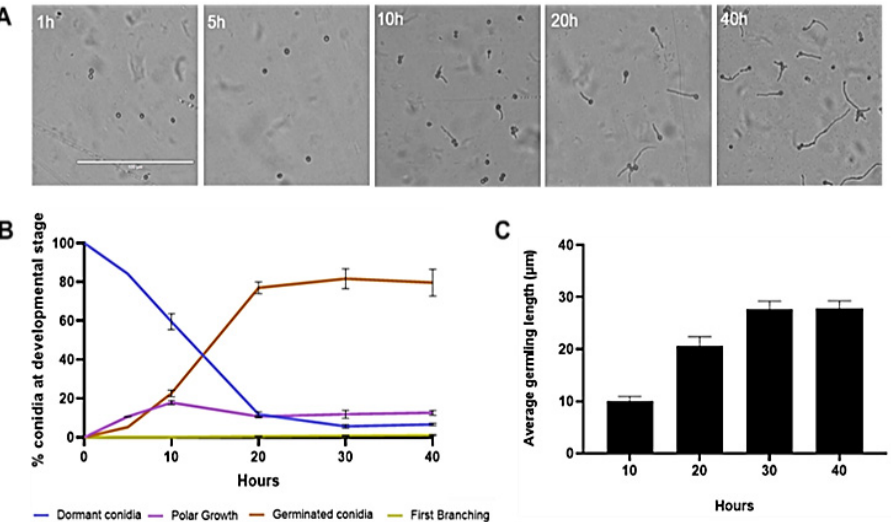
Figure 10. Phenotypic characterization of conidia germinating on R. solani host. ( A ) Conidia ger- minated on R. solani were imaged at different time points, as indicated. Scale bar: 100 µ m for all images. ( B ) Conidial germination as a percentage over time, determined by live-cell imaging. ( C ) Average germling length, quantified by n = 50 randomly selected conidia for each time point. Error bars describe standard deviations of the mean for three biological